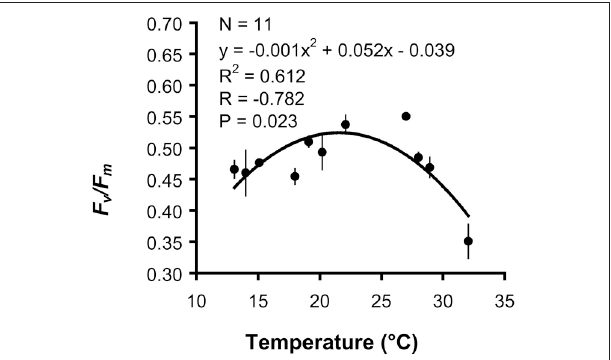
FIGURE 2 | Balanophyllia europaea . Regression and correlation analysis between mean maximum quantum yield ( F v /F m ) and temperature using a quadratic function model. Error bars represent the standard error. N number of temperature treatments.